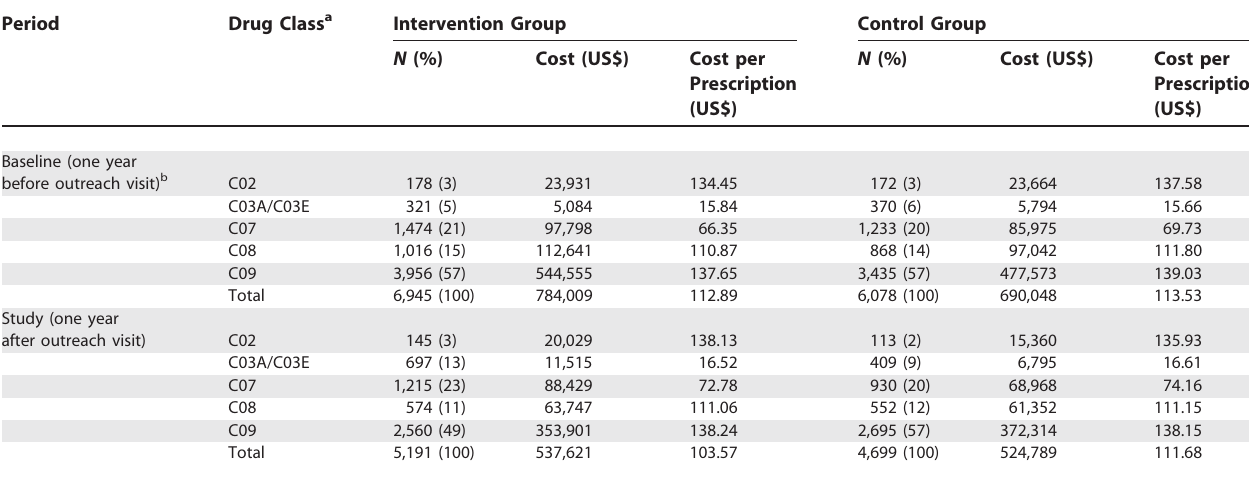
Table 3. Number of Prescriptions and Drug Costs during Study and Baseline Periods Period Drug Class